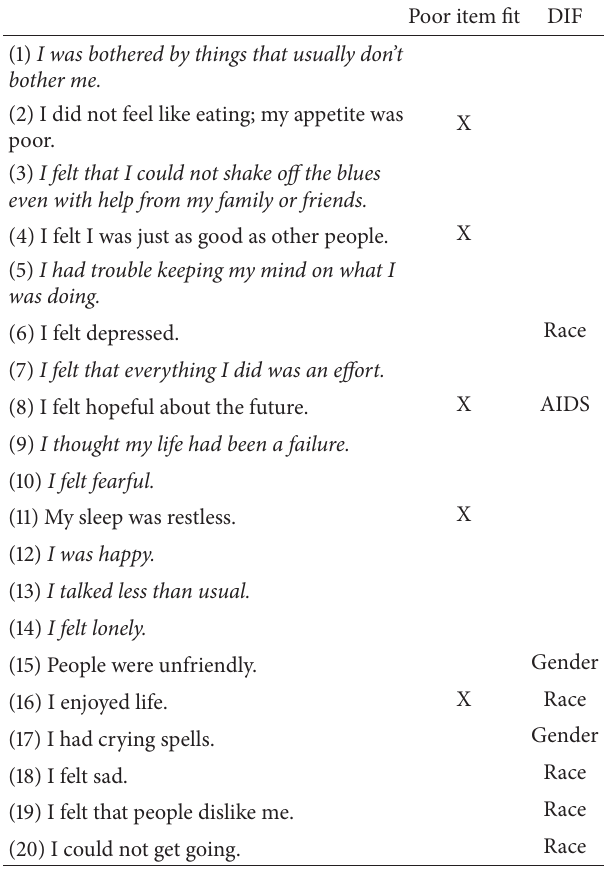
Table 3: CES-D items demonstrating poor fit or differential item function.